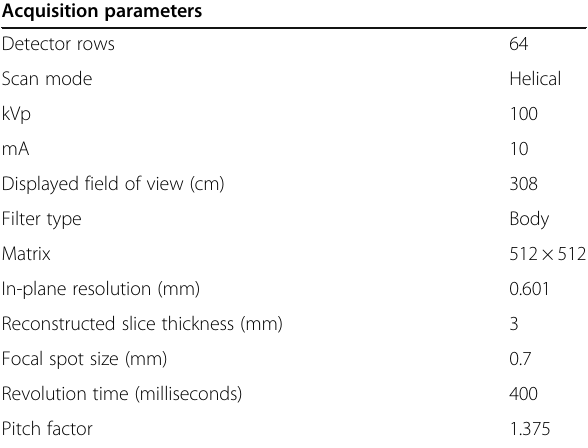
Table 1 Computed Tomography acquisition parameters Acquisition